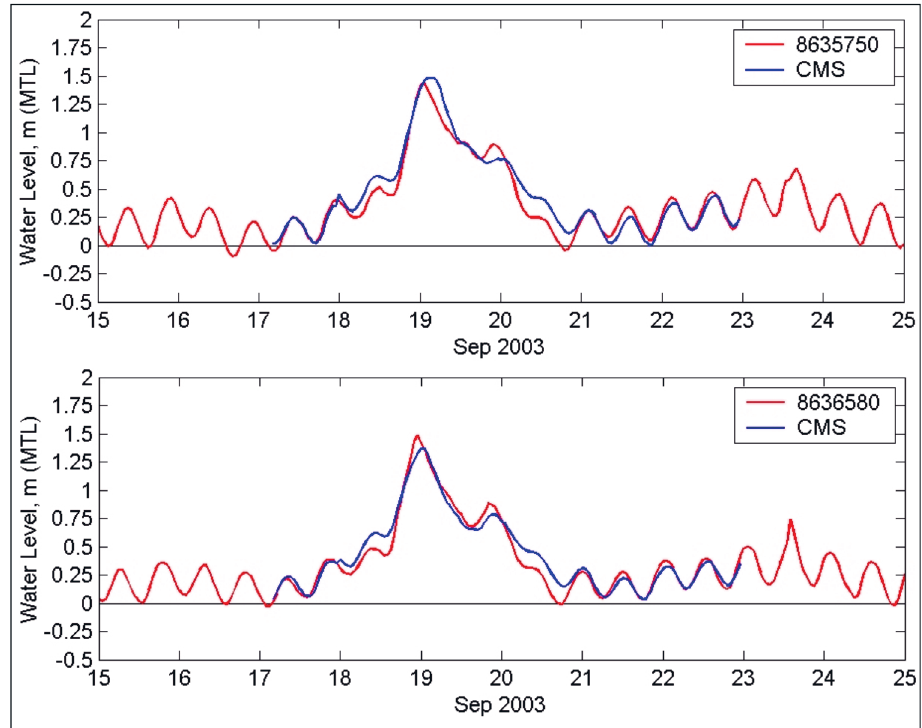
Figure 30. Calculated and measured water levels at NOAA Stations 8635750 (Lewisetta, VA) and 8636580 (Windmill Point, VA) under Hurricane Isabel.